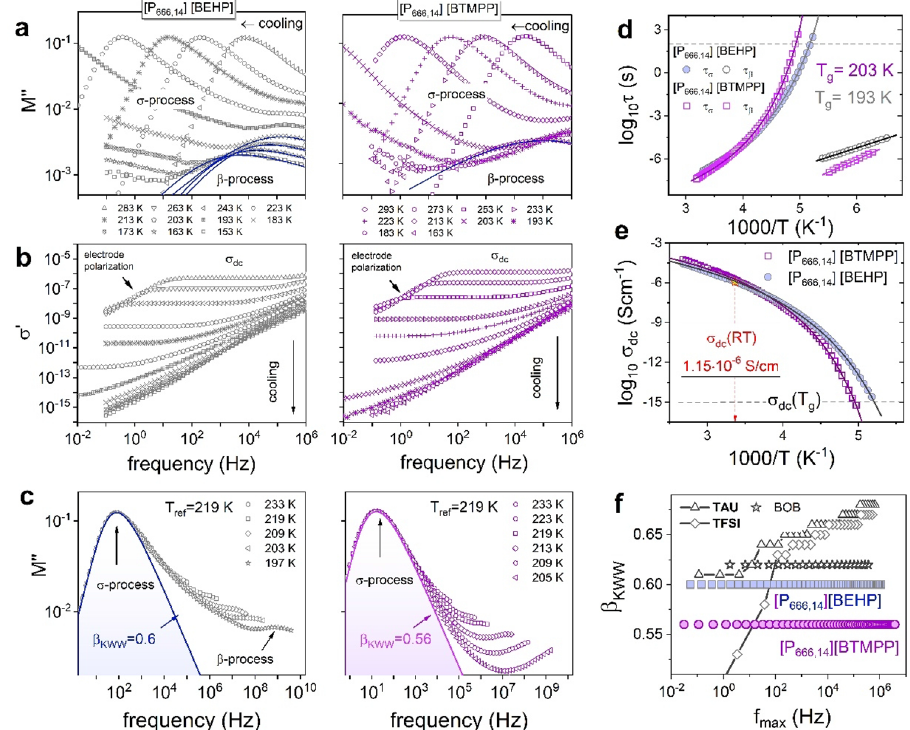
Figure 2. Dielectric response of examined ILs measured at ambient pressure. ( a ) Imaginary part of the complex electric modulus M ’’ and ( b ) real part of complex conductivity σ ’ as a function of frequency at various temperatures for [P 666,14 ][BEHP] and [P 666,14 ][BTMPP]. ( c ) Superimposition of M ’’ spectra of [P 666,14 ][BEHP], [P 666,14 ][BTMPP] at 0.1 MPa and several temperatures. ( d ) Temperature dependence of conductivity relaxation times above and below T g . ( e ) Temperature dependence of dc-conductivity. Solid lines in ( d ) and ( e ) denote the fits of the VFT equation to experimental data above T g and the fits of Arrhenius law for the secondary relaxation process below T g . Adj. R-Square of VFT fits is equal to 0.9999 and 0.9992 for [P 666,14 ][BEHP], [P 666,14 ][BTMPP], respectively. ( f ) β KWW as a function of M ”(f) peak maximum for [P 666,14 ][BEHP], [P 666,14 ][BTMPP] and